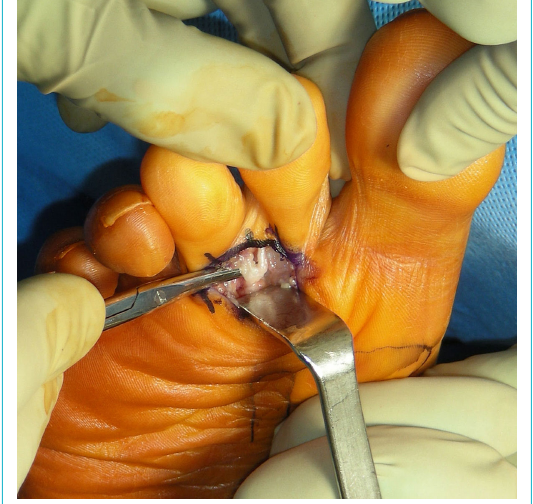
depth of the exposure. Kaplan placed the incision at the root of the toes, slightly proximal to the interdigital folds.